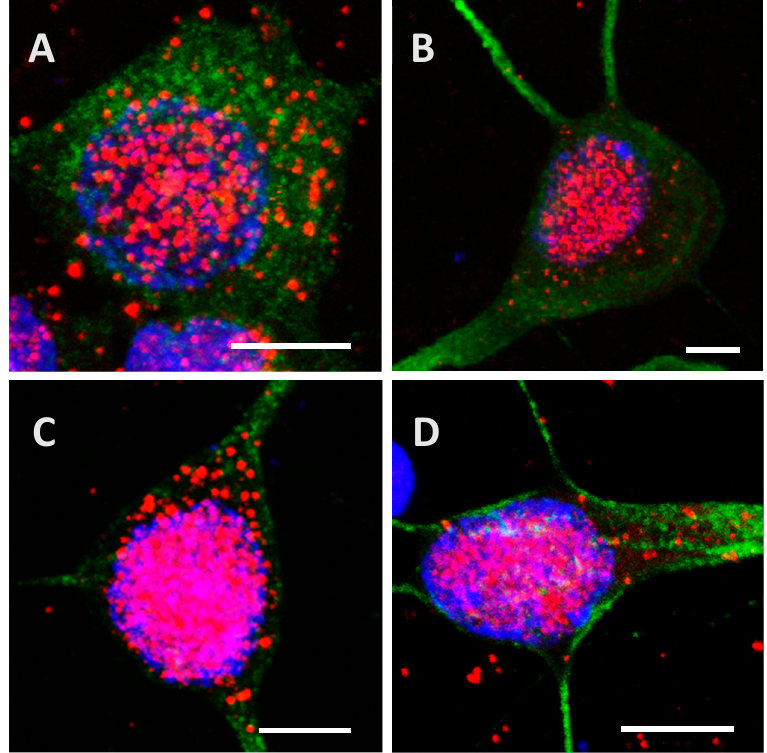
Figure A2. Internalization and processing of the Tau protein (15 μ g; A , B ) and its highly phosphorylated form (1.5 μ g; C , D ) by cortical cells. Following 24 h ( A , C ) or 48 h ( B , D ) of incubation with protein, cells were immunostained with a mouse anti ‐ His ‐ tag antibody targeted by an AlexaFluor ® 594 antibody (red) and with a rabbit anti ‐ MAP2 antibody targeted by an AlexaFluor ® 488 antibody (green). Nuclei were stained with DAPI. The protein was sometimes detected outside cells where it was probably attached to the extracellular matrix. Different digital zooms were applied to the 60× optical zoom: A: 2.6×, B: 2.8×, C: 2.1×, D: 3×. All scale bars correspond to 5 μ m.